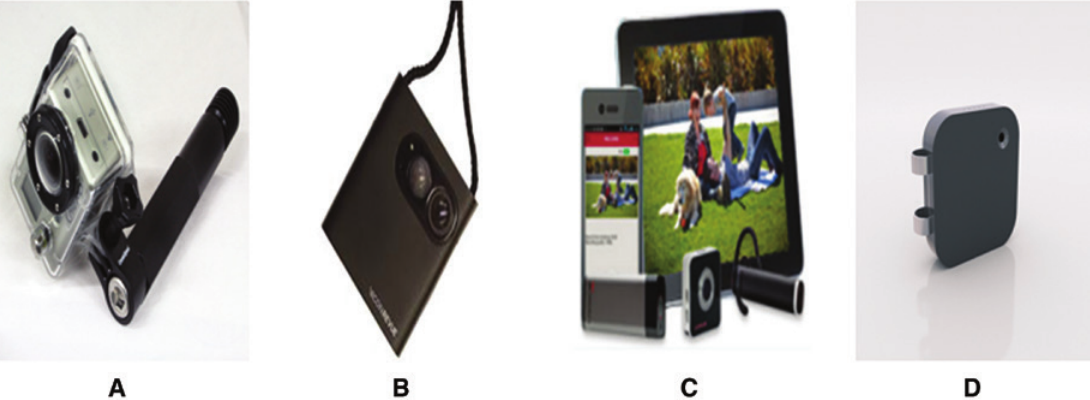
Figure 1: A variety of life-logging wearable devices: (A) GoPro (2002). (B) SenseCam (2005). (C) Looxcie (2011). (D) Narrative